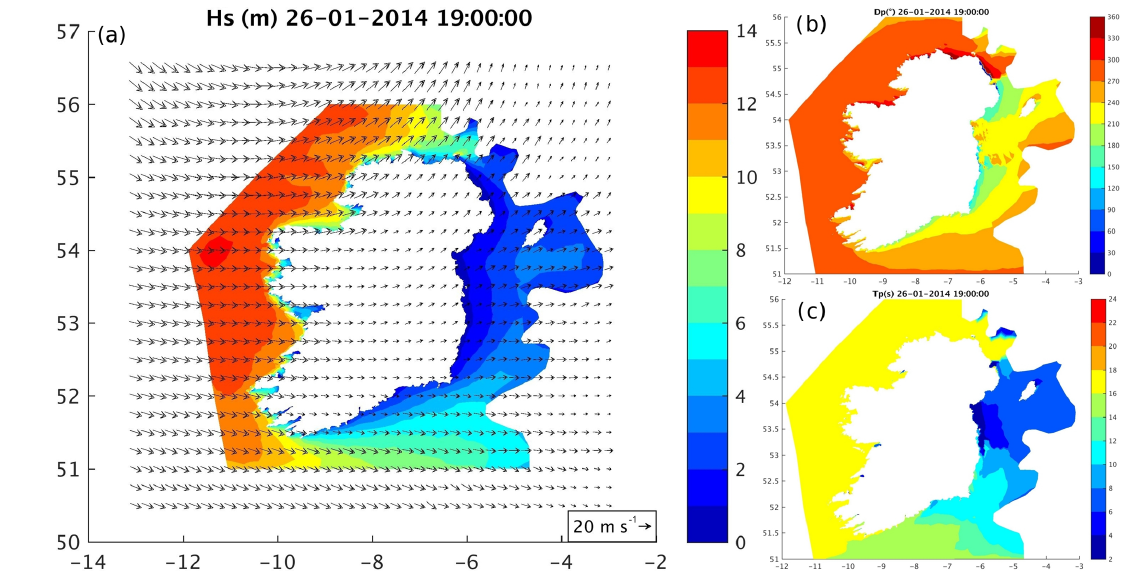
Figure 15. Maps of (a) significant wave height (m) with vectors representing wind speed (ms − 1 ) and direction ( ◦ ), (b) peak wave direction ( ◦ ), and (c) peak wave period (s) at 19:00UTC on 26 January